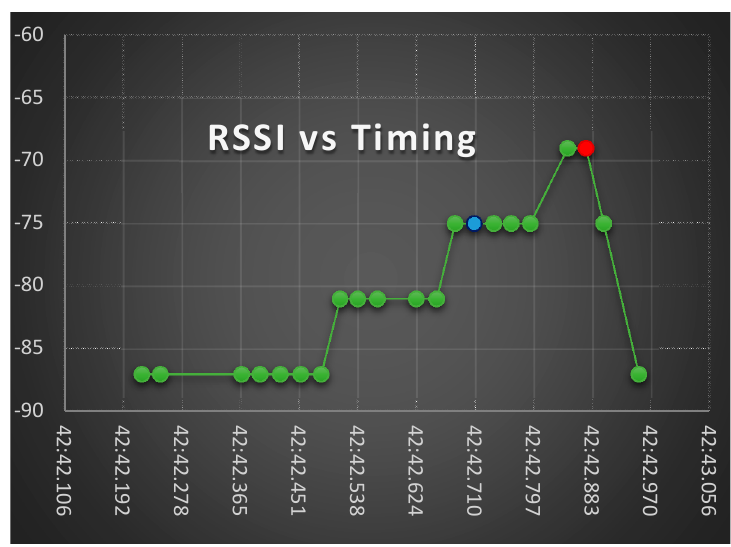
Figure 16. The RSSI on the BLE Receiver related to the receiving time. Table 7. The dynamic experiment when the Tx power of the BLE Tag on the instep is set at Level 3. On Instep Tx Level 3